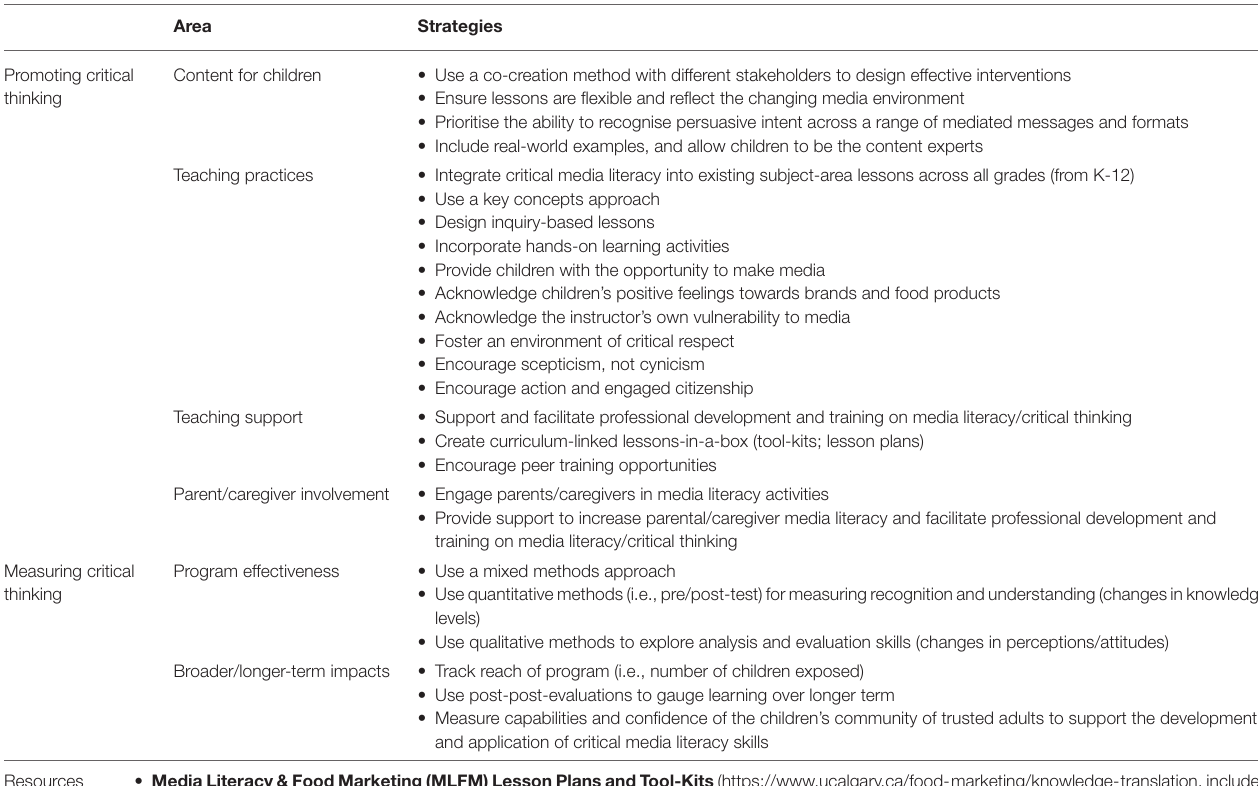
TABLE 1 | Strategies for promoting and measuring critical thinking in intervention